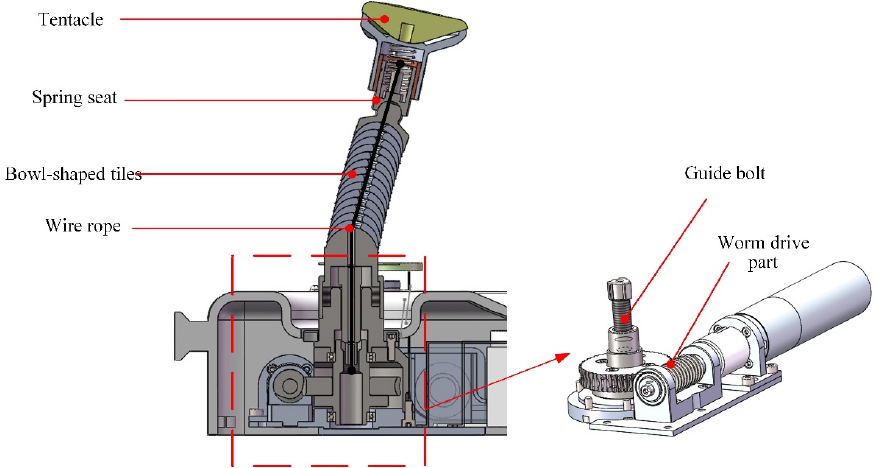
Figure 2. The structural design details of the proposed snake arm.